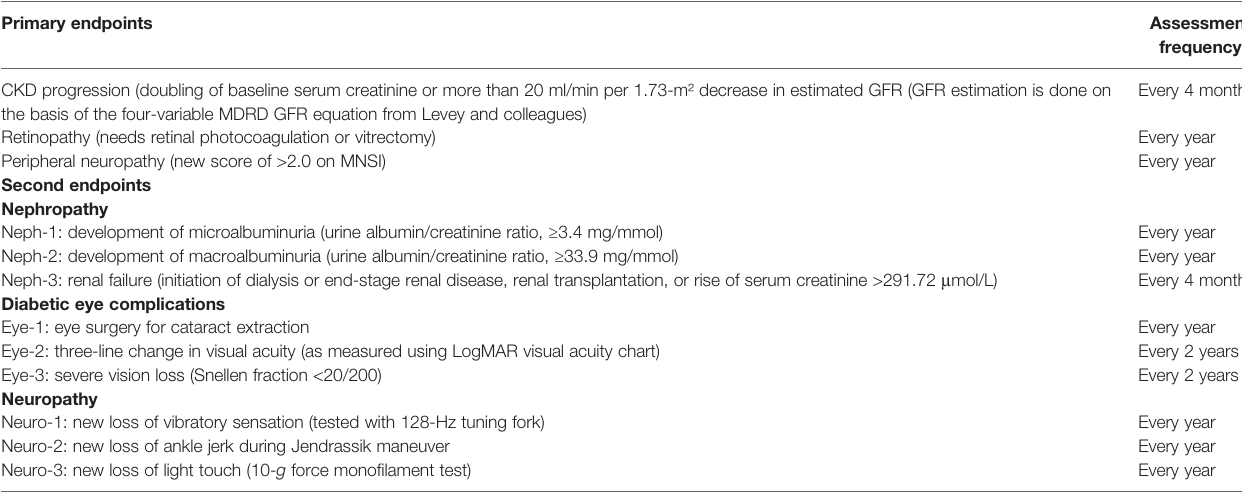
TABLE 1 | Primary and secondary endpoints and assessment frequency. Primary endpoints